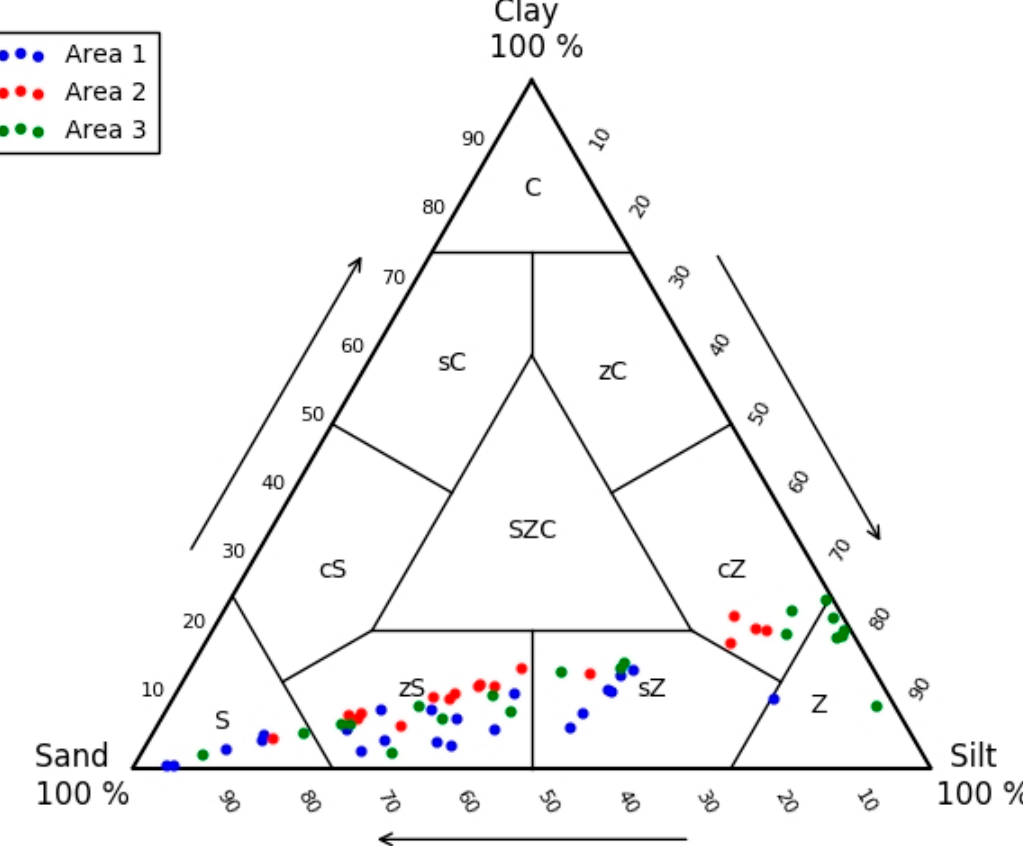
Figure 8. Ternary diagram illustrating the relative proportions of Sand, Silt, and Clay (after [47]) Fig 8 indicating the dominance of silt over clays in the muddy sediments of the Oceanic